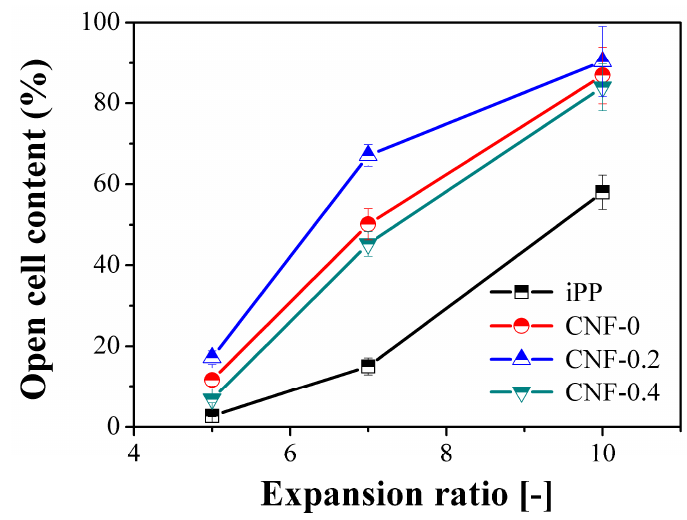
Figure 5. Open cell content for iPP and PP/CNF nanocomposite foams as a function of the expansion ratio.